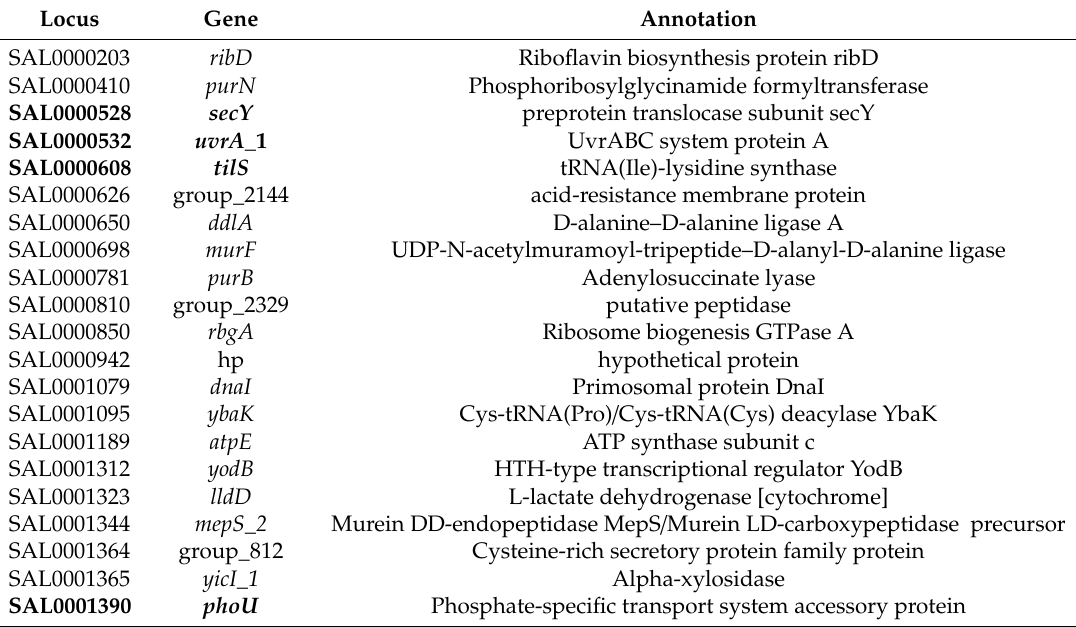
Figure 4. Development of the LA1063 strain-specific PCR-based identification method. Heatmap and neighbor-joining tree of the analyzed the 41 Lactobacillus acidophilus strains based on the presence or absence of genes. Arrows indicate strain-specific markers for Lactobacillus acidophilus LA1063 and BCRC 17481 strains. Table 5. Strain-specific loci for Lactobacillus acidophilus LA1063.